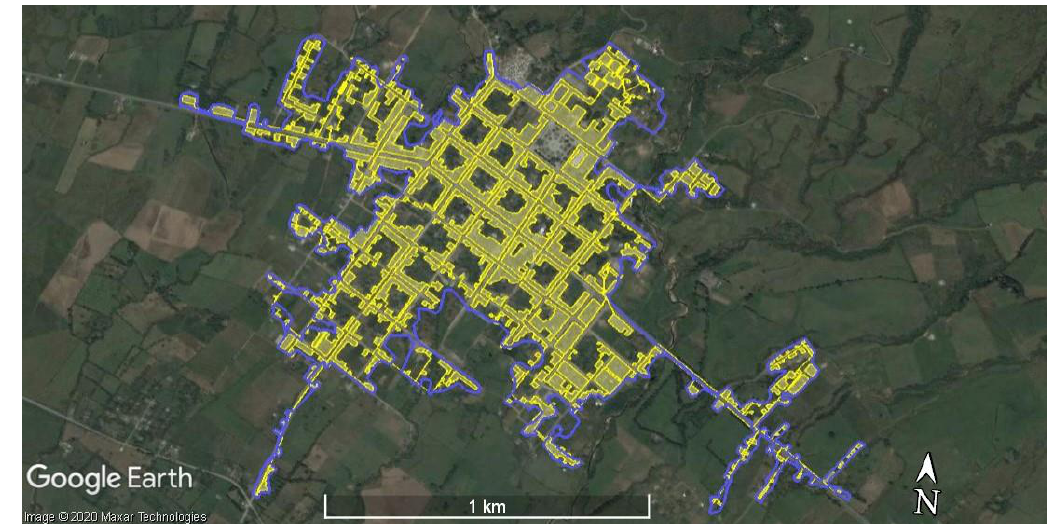
Figure 8. Area of the roofs of the municipality of Sibundoy. Source: Modified from Google Earth.